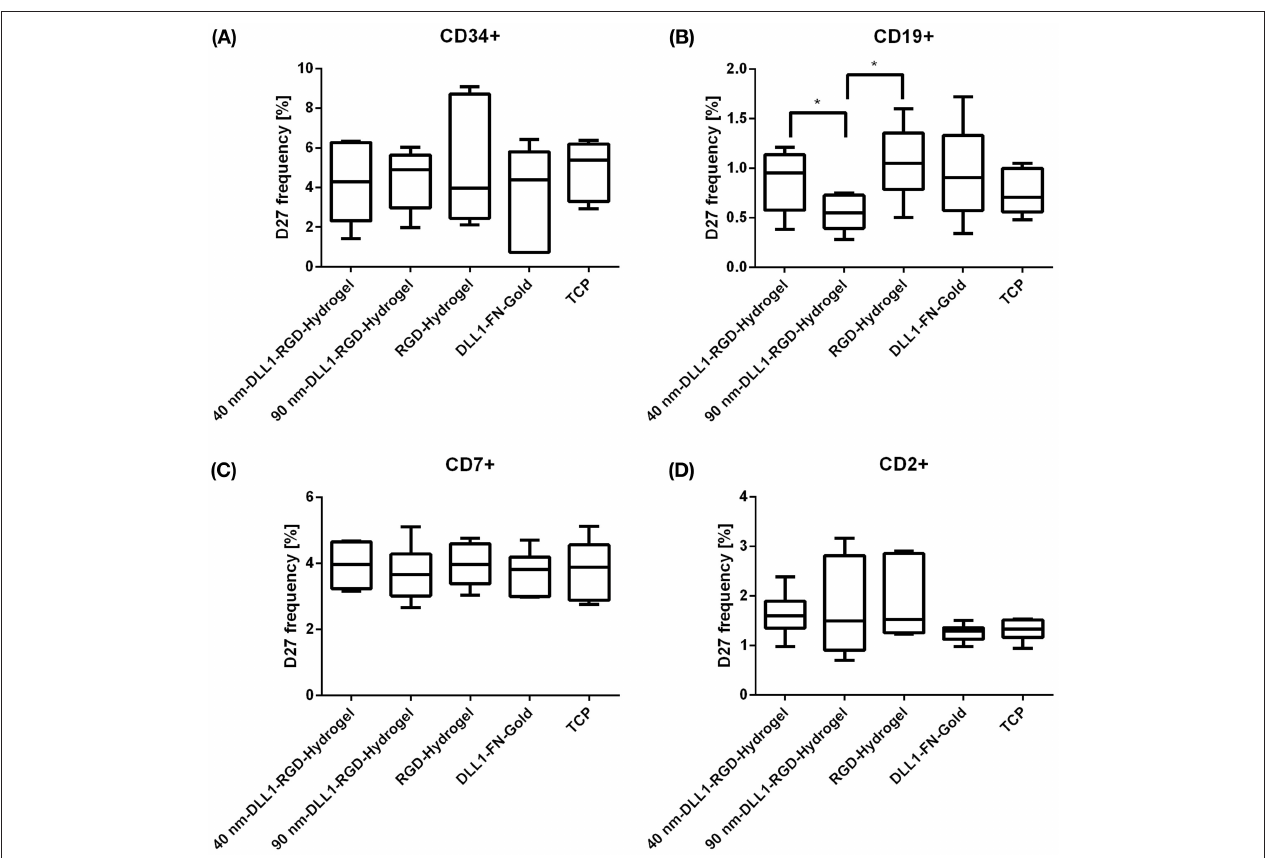
FIGURE 4 | Expression of cell surface markers indicating the stage of T cell differentiation from human UCB CD34 + cells. CD34 + cells were exposed to DLL1-nanostructured and pure RGD-PEGDA hydrogels as well as DLL1-non-structured fibronectin gold substrates in culture of 27 days. DLL1 nanopattern defines an intermolecular spacing of ∼ 40 and 90nm, respectively. Cultured cells were analyzed by flow cytometry for surface expression of stem cell marker CD34 (A) , B cell marker CD19 (B) , CD7 as early T cell marker (C) and for a later maturational stage CD2 (D) . Data represent percentage of marker positive cells as box plots from N = 6 wells of identical surface types from three independent experiments. TCP, tissue culture plastic; FN, fibronectin. Significant differences are indicated * P < 0.05.